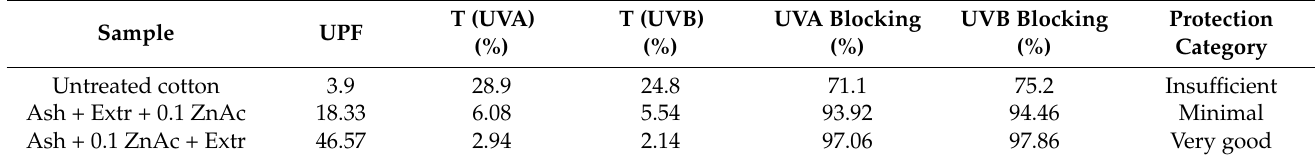
Table 1. Ultraviolet protection factor (UPF), transmission of UVA and UVB radiation (T(UVA) and T(UVB)), UVA and UVB blocking and the protection category of the cotton samples.